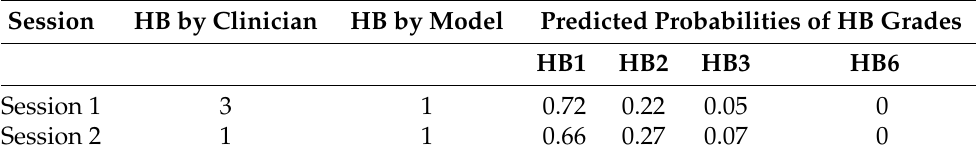
Table 15. Classification by OLR model for the misclassified